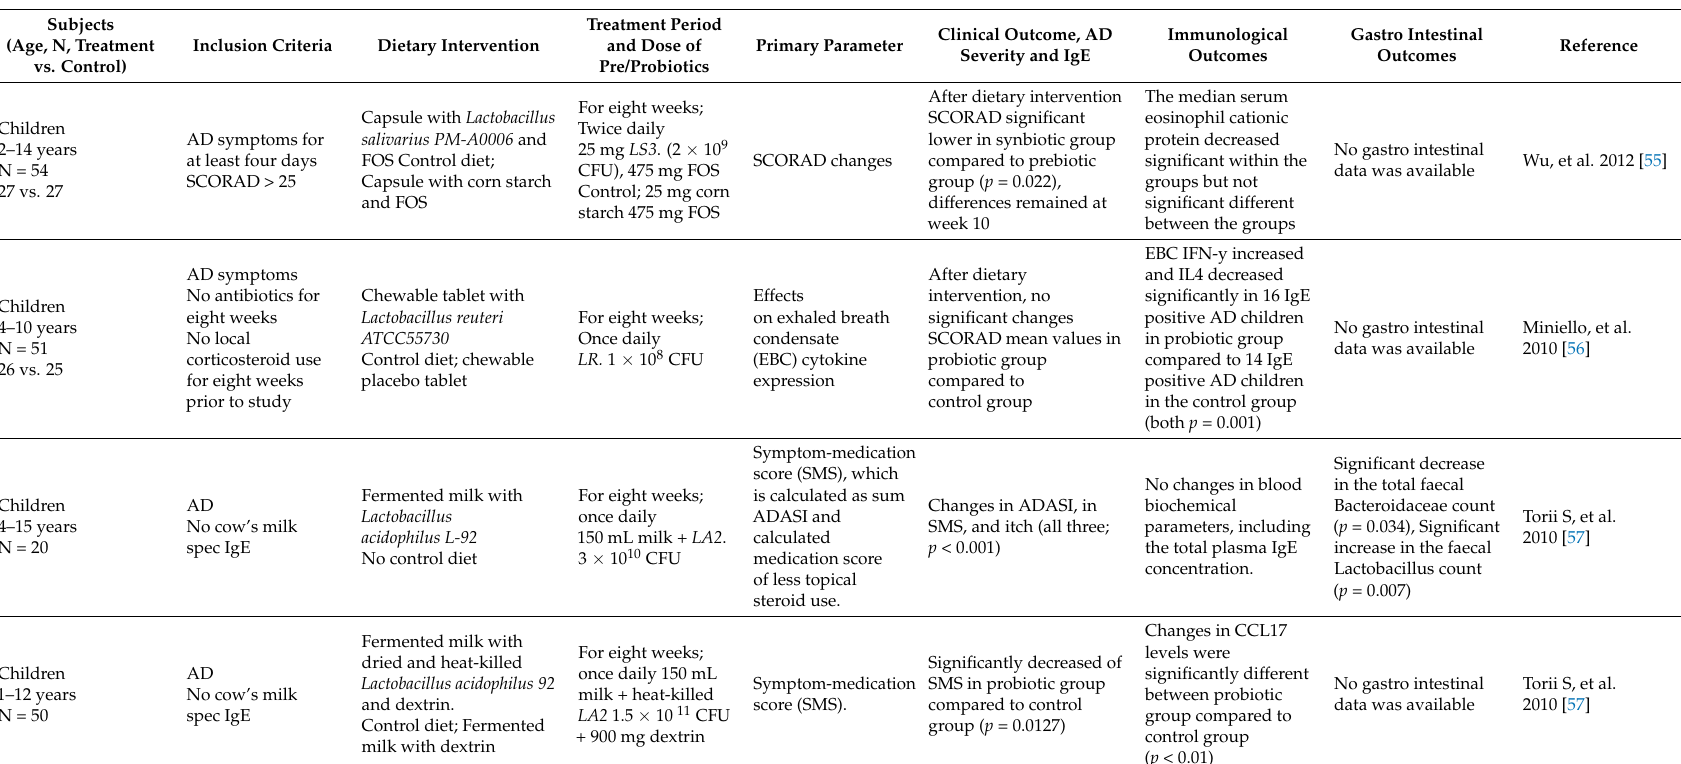
The clinical dietary intervention studies have been ordered according to the age of the children at inclusion. Abbreviations Table 1: AD, atopic dermatitis; IgE, Immunoglobulin E; HA, hydrolysed infant formula; GOS, galacto-oligosaccharides; SCORAD, scoring atopic dermatitis score; FOS, Fructo-oligosaccharides; BB, Bifidobacterium breve M-16V ;